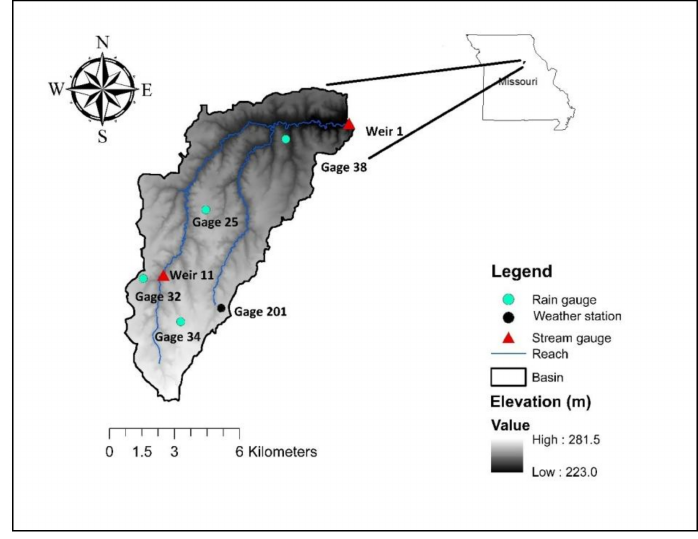
Figure 1. Goodwater Creek Experimental Watershed showing rain gauges and weir outlets.